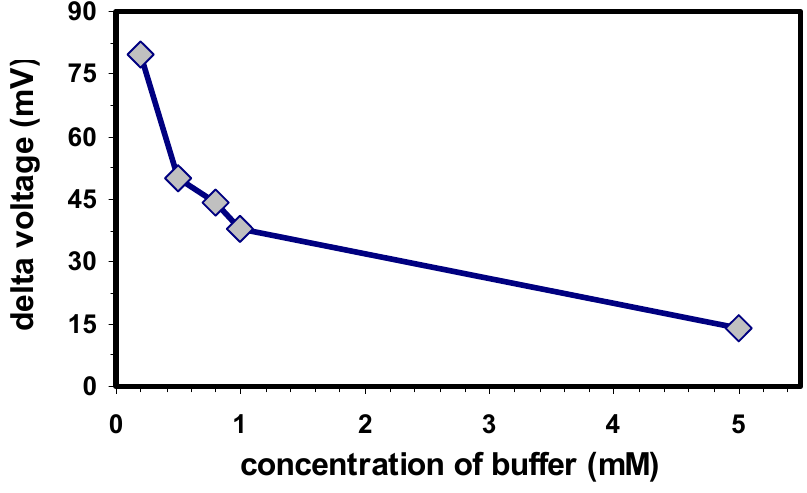
Figure 3. Effect of the HEPES buffer concentration on the response of the EIS biosensor; measuring conditions: pH 9, 50 µM CoCl , 100 mM NaCl, 100 µM paraoxon. 2